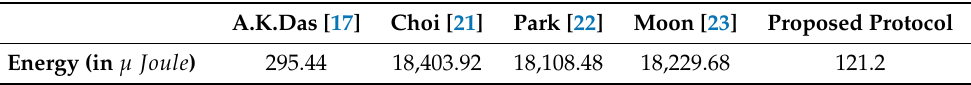
Table 28. Comparison of protocols based on energy consumption on sensor node SN j .